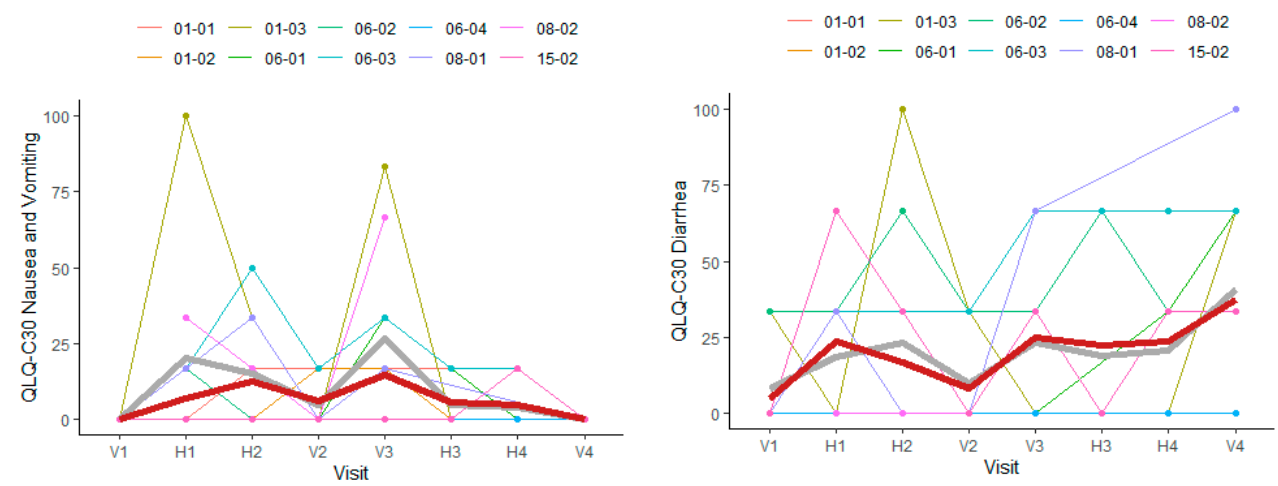
Figure 3. Examples of short-term fluctuations in symptoms. (a) Ten individual and mean data for nausea and vomiting, EORTC QLQ-C30 question- naire. Total mean plotted bold in grey (n = 10), pazopanib arm mean plotted bold in red (n = 8), V1–4, symptoms recorded at regular visits 1–4, H1–4, home based ePRO data (Figure 3 left). Ten individual and mean data for diarrhea, EORTC QLQ-C30 questionnaire. To- tal mean plotted bold in grey (n = 10), pazopanib arm mean plotted bold in red